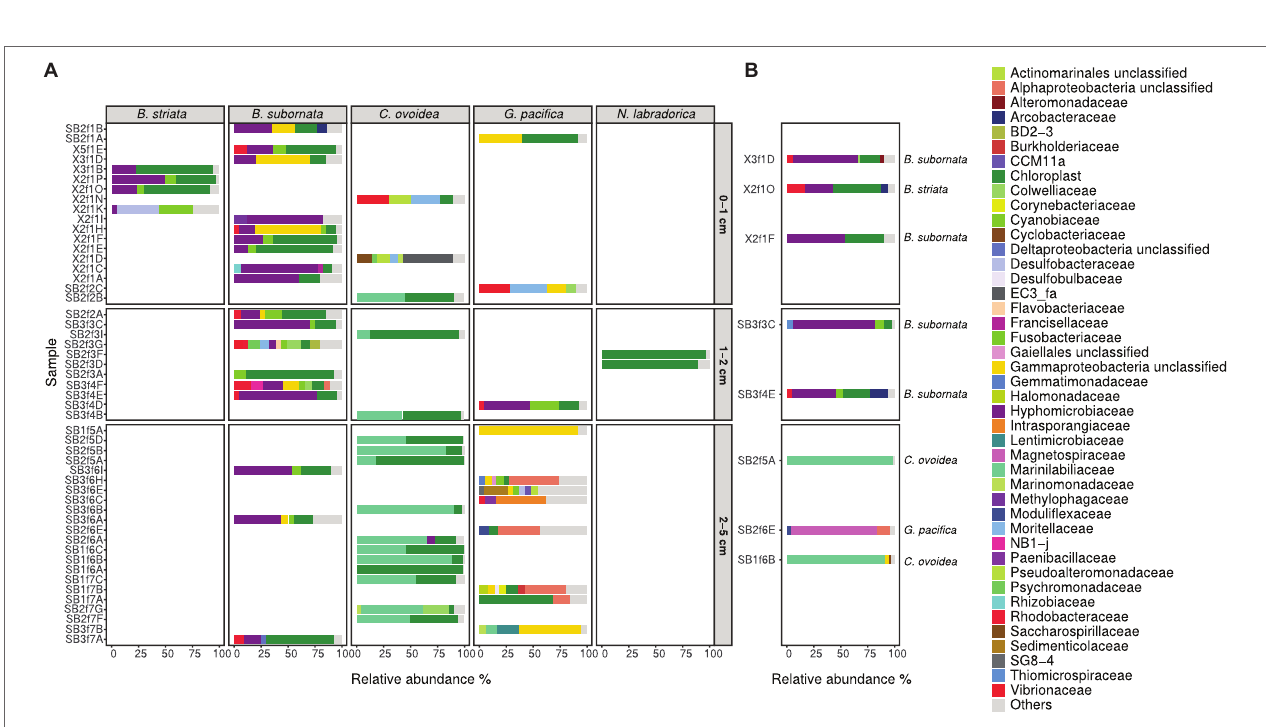
FIGURE 6 | Relative abundance of bacterial families in foraminiferal samples at different sampling depths based on Illumina MiSeq sequencing (A) and full-length sequencing (B) of the 16S rRNA gene. Bacterial families with RA over 4% (A) and 2% (B) are shown; taxa present with lower RA are grouped in